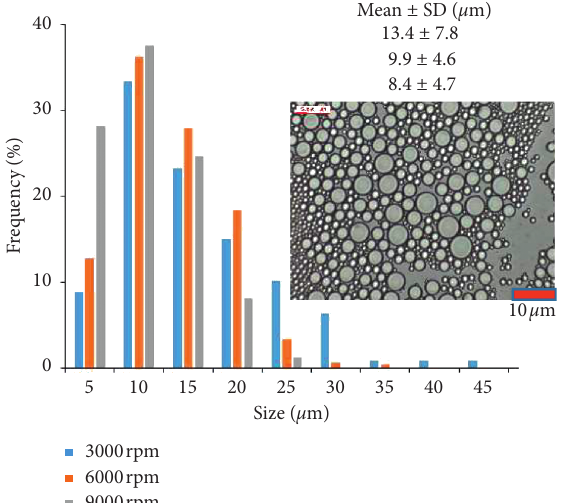
Figure 4: Influence of homogenization speed on the size distribution of HKG-gelatin coacervates. Inset: an example of optical microscopic images used for size analyses.